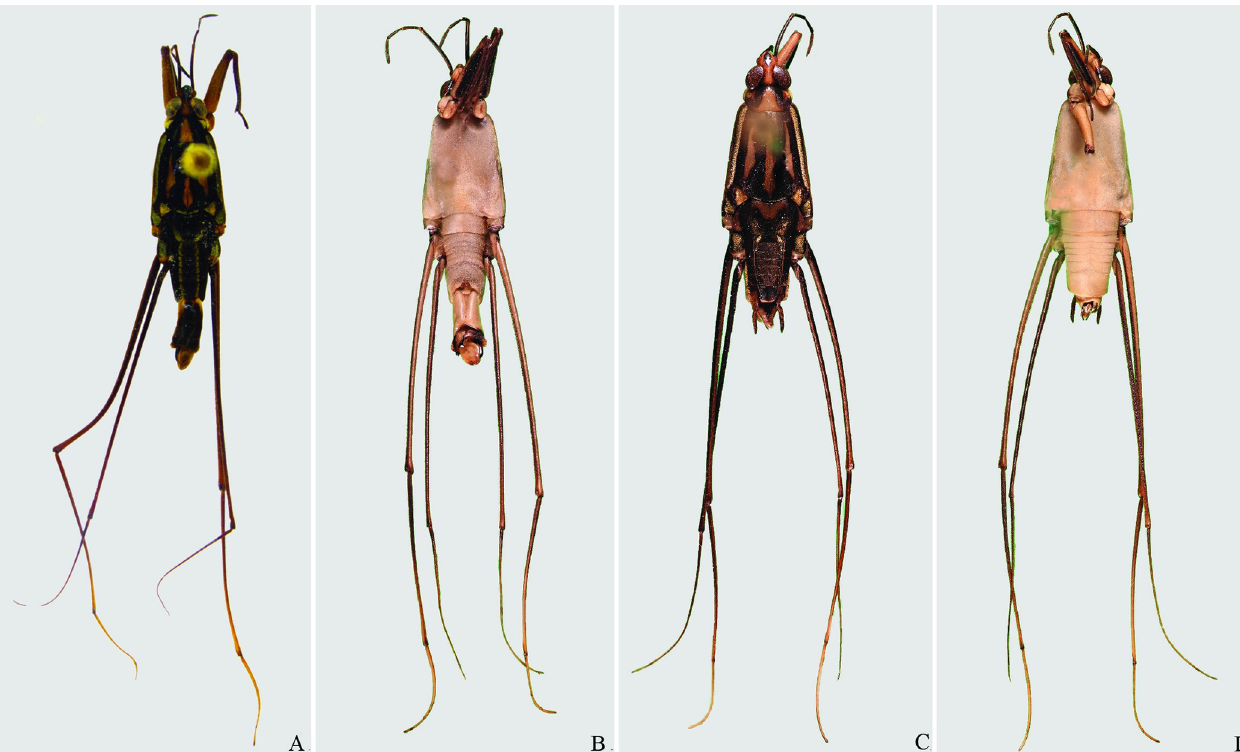
Fig 26. Potamobates shuar . (A) Male, dorsal view; (B) male, ventral view; (C) female, dorsal view; (D) female, ventral view.